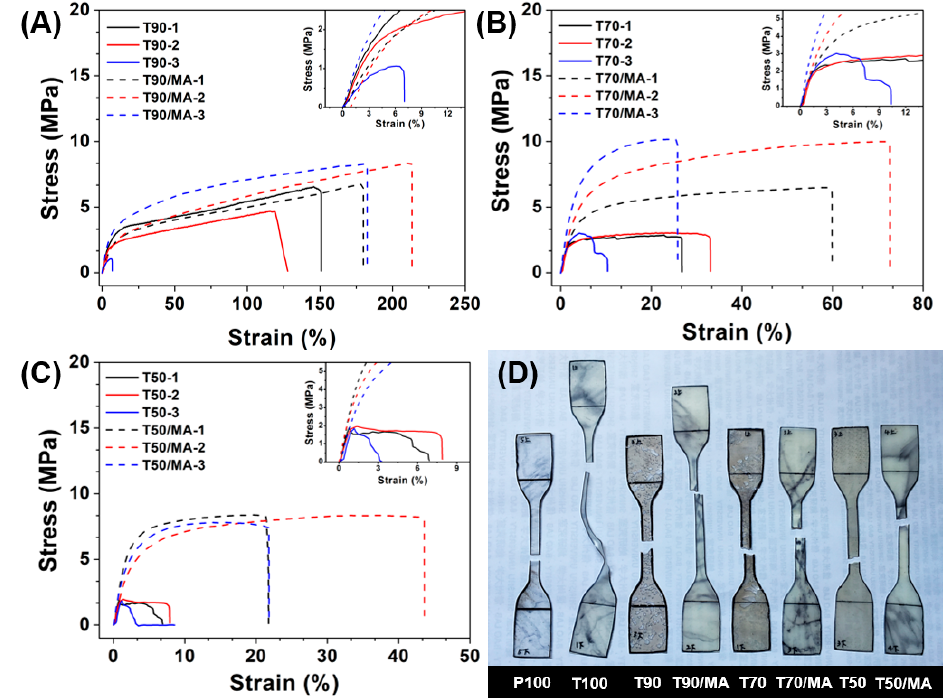
Figure 4. Tensile performance of T/P and T/P/MA groups as related to the melting–recycling cycles: ( A )–( C ) stress–strain curves; ( D ) practical samples after tensile property tests. ** 1: one-off hot-pressing, 2: the post-2nd-recycling, and 3: the post-3rd-recycling.